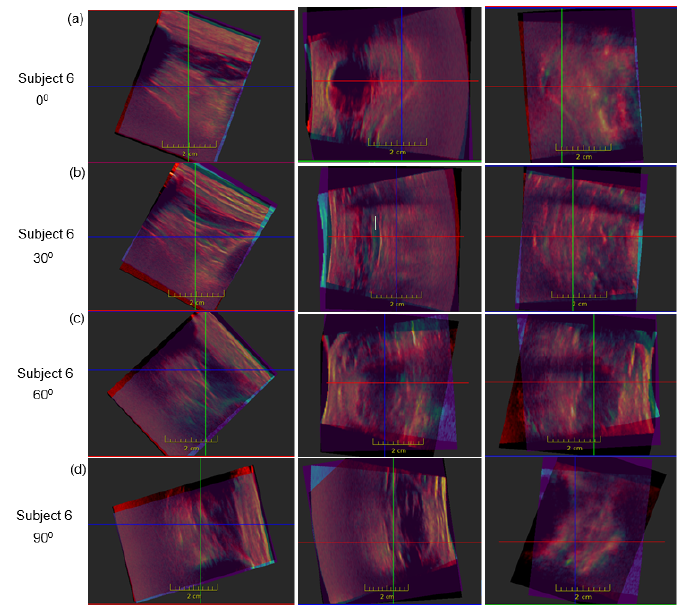
Figure 9. Output of proposed registration method for subject 6 overlaid on its respective ground truth for all four of the flexion angles. The output of the proposed algorithm is shown in red and ground truth for the study is shown in